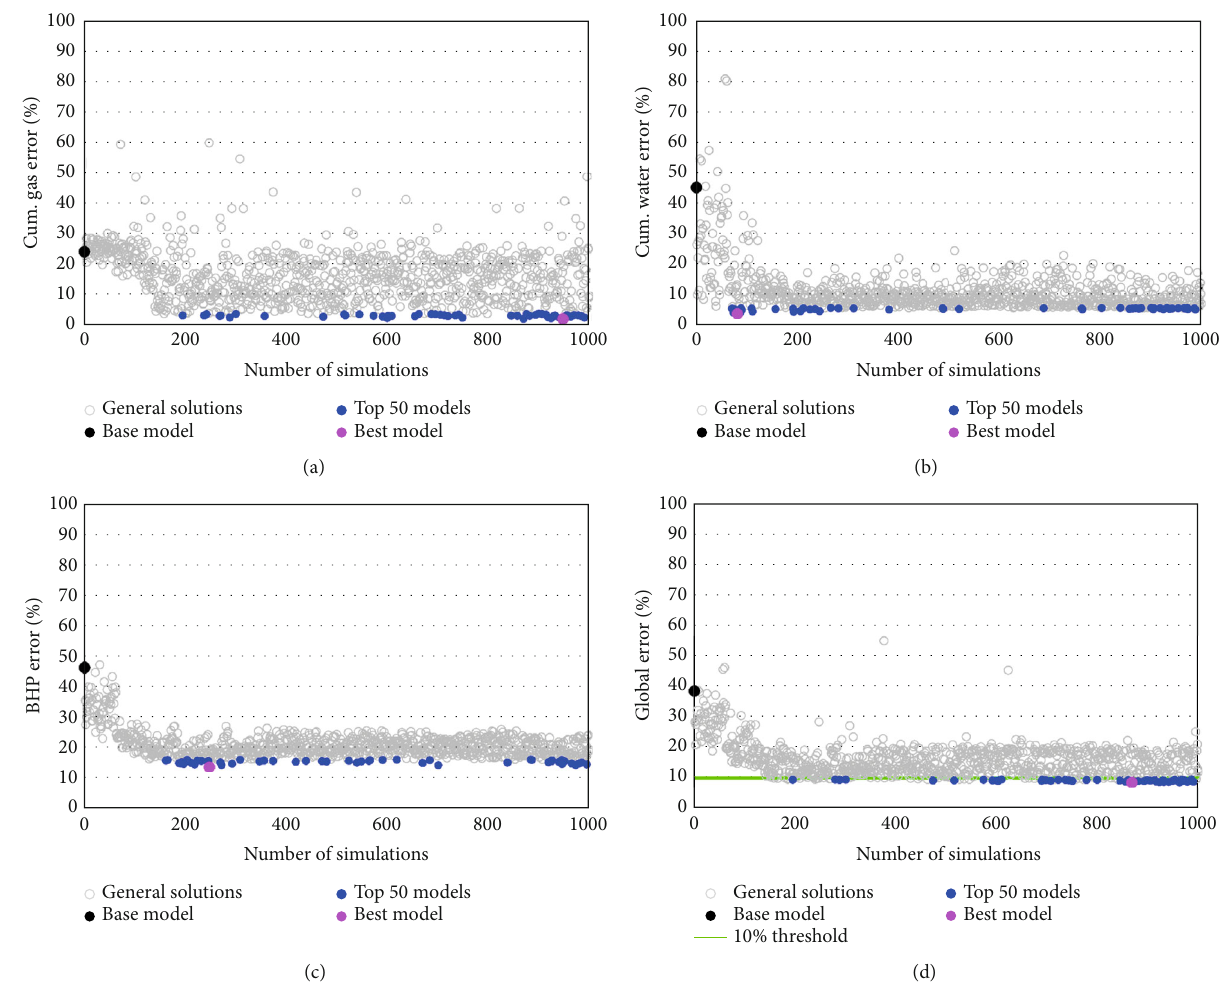
Figure 8: History matching results in terms of errors: (a) cumulative gas production, (b) cumulative water production, (c) bottom-hole pressure, and (d) the global